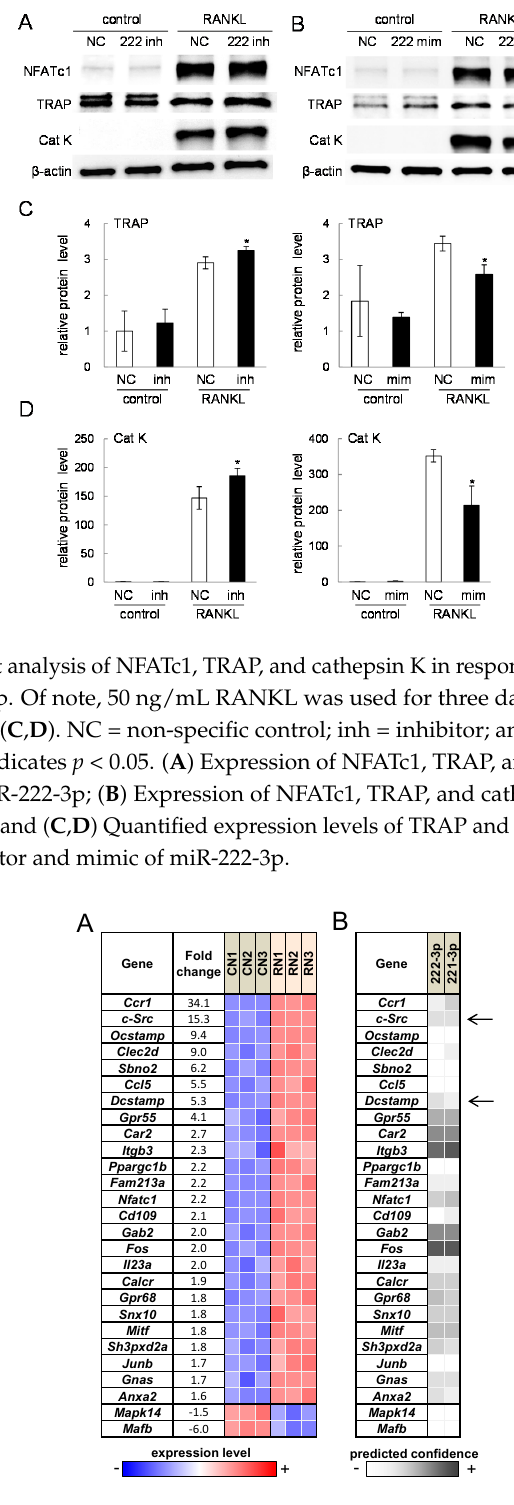
Figure 6. RANKL responsive genes and their potential link to miRNAs. ( A ) Heat map of RANKL-responsive genes that are related to osteoclasts. The blue and red colors indicate downregulation and upregulation, respectively. Note that CN1, CN2, and CN3 are control samples, and RN1, RN2, and RN3 are RANKL-treated samples; and ( B ) Predicted link between RANKL-responsive genes and miRNAs. The grey code indicates a confidence measure of in silico prediction. The arrows indicates they were chosen for further study.